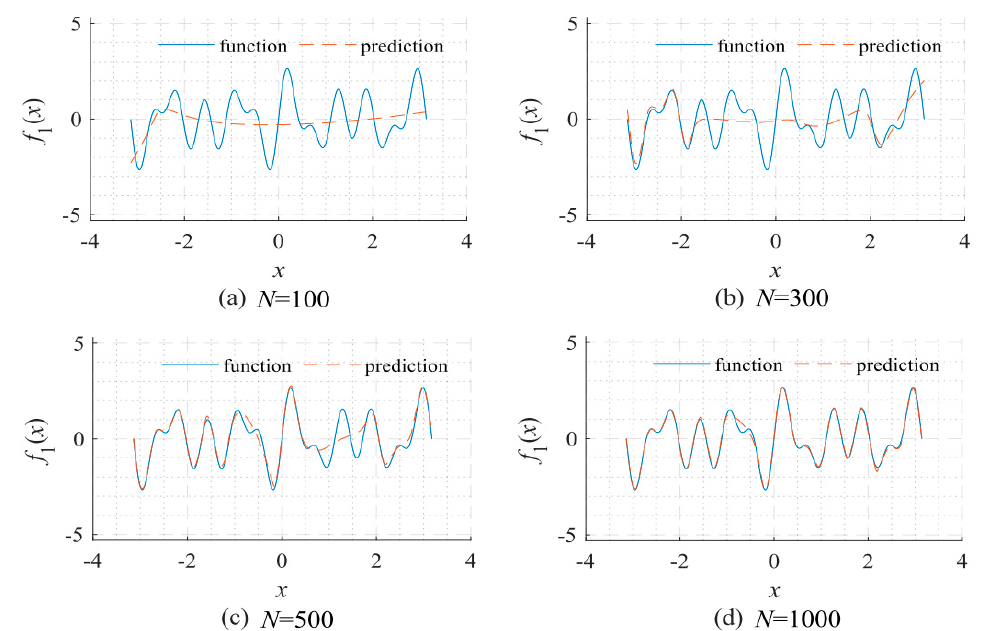
Figure 1. Network fitting results given a different number of updates reflects that neural networks often learn low-frequency components first in the training process: ( a ) N = 100; ( b ) N = 300; ( c ) N = 500; and ( d ) N = 1000. The objective function for fitting: f 1 = sin5 x + sin7 x + sin11 x . The network used a 1-40-40-40-40-1 fully connected structure type. The Adam optimizer was used for optimization under the default learning rate.